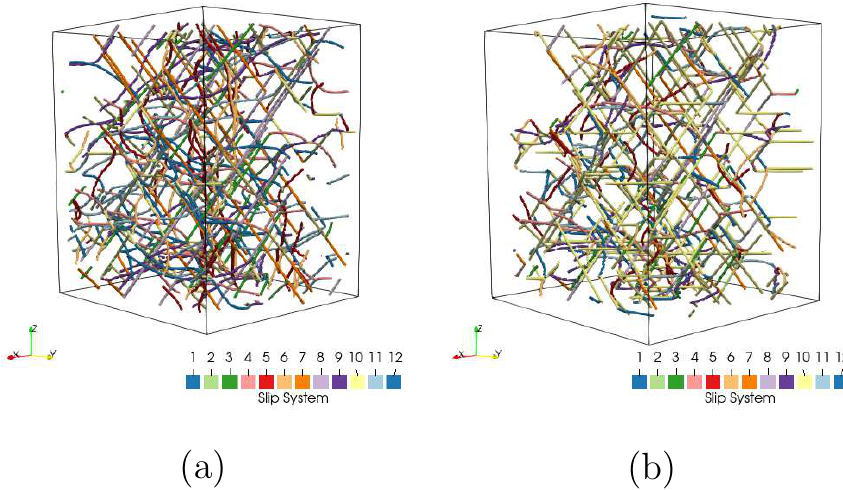
Fig. 15: The dislocation morphology evolution predicted Figure 15. The dislocation morphology evolution predicted by a DDD simulation: ( a ) at the initial status; ( b ) after yielding. by a DDD simulation: (a) at the initial status; (b) after yielding.